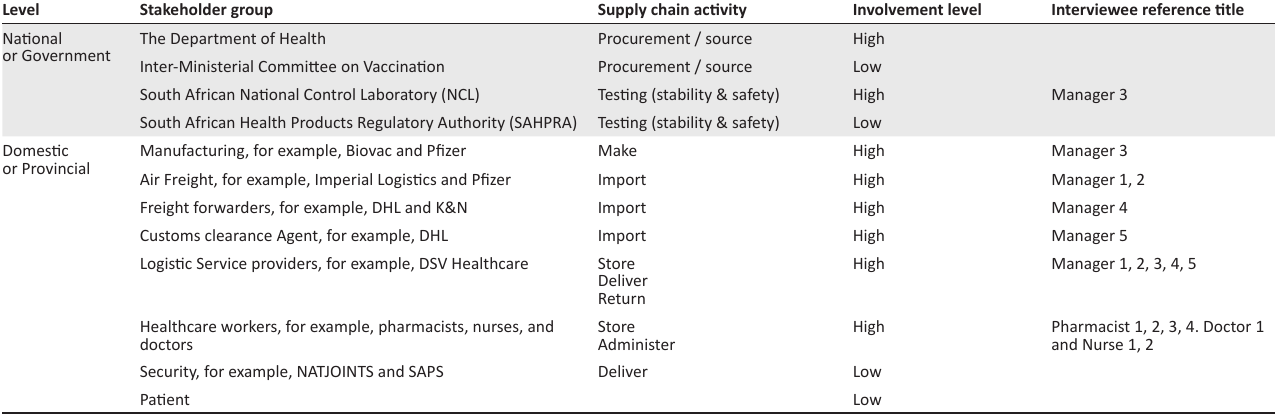
TABLE 1: COVID-19 vaccine supply chain stakeholder list (Toolkit element 1).